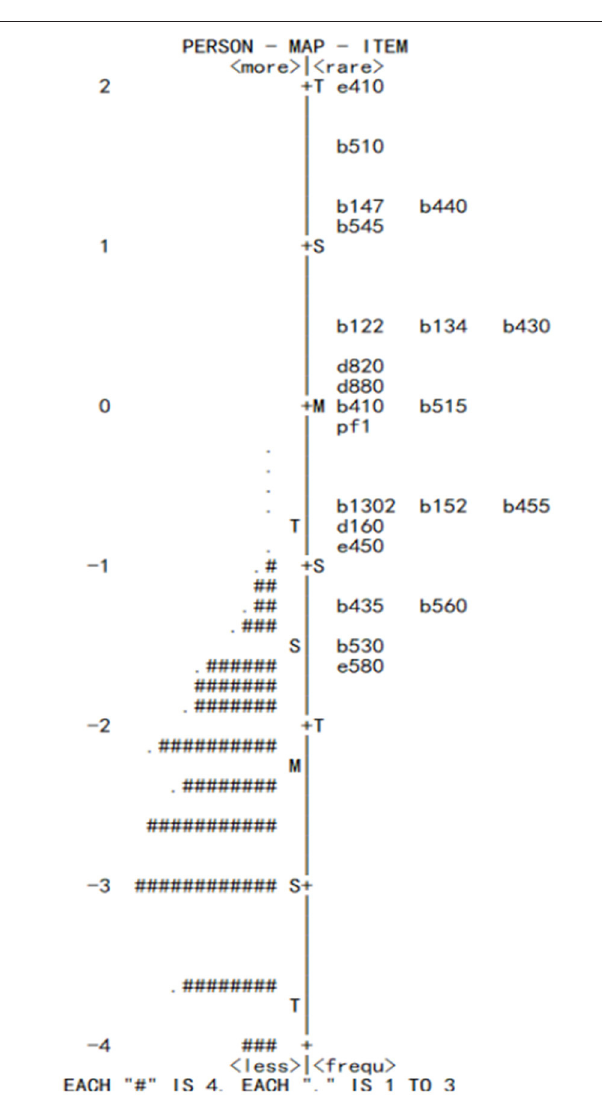
FIGURE 3 | Item map of the 22-categories of the ICF-CY-CHDS for the children after CHD surgery in the first year.